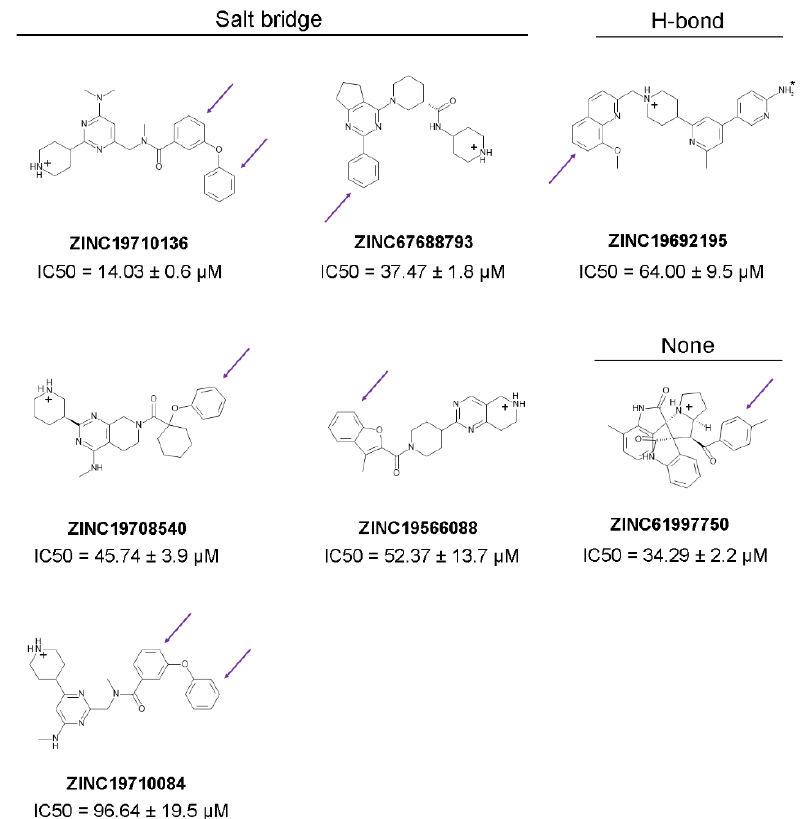
Figure 13. Structures of compounds identified in the virtual screening with IC 50 < 100 µM. The predicted positive charge of the molecules at pH 7.0 is indicated by a plus sign. Five ligands form a salt bridge with C-terminus of NMT though a positively charged piperidine ring. The amino-group of ZINC19692195 (indicated by a small asterisk), forms a hydrogen bond with the C-terminus of NMT1. ZINC619997750 is a natural product that does not interact with the C-terminus of NMT. Distal benzene rings are indicated by arrows.